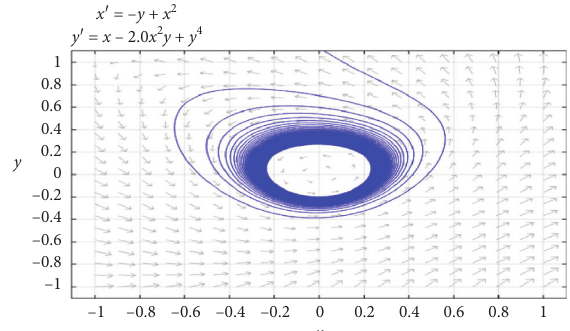
Figure 6: Existence of limit cycle of system (6), when k � 1 ,l � 0 , m � − 0 . 2 , and n �